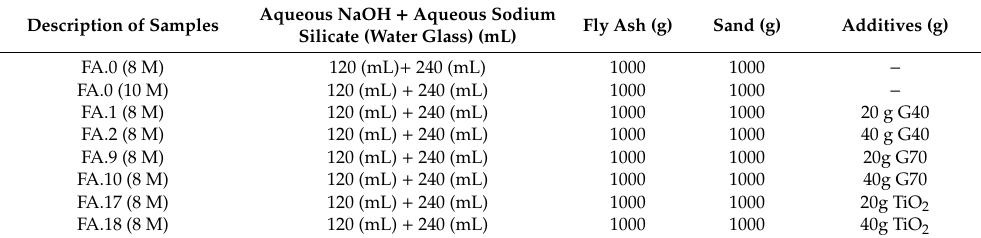
Table 3. Composition of geopolymer composites with